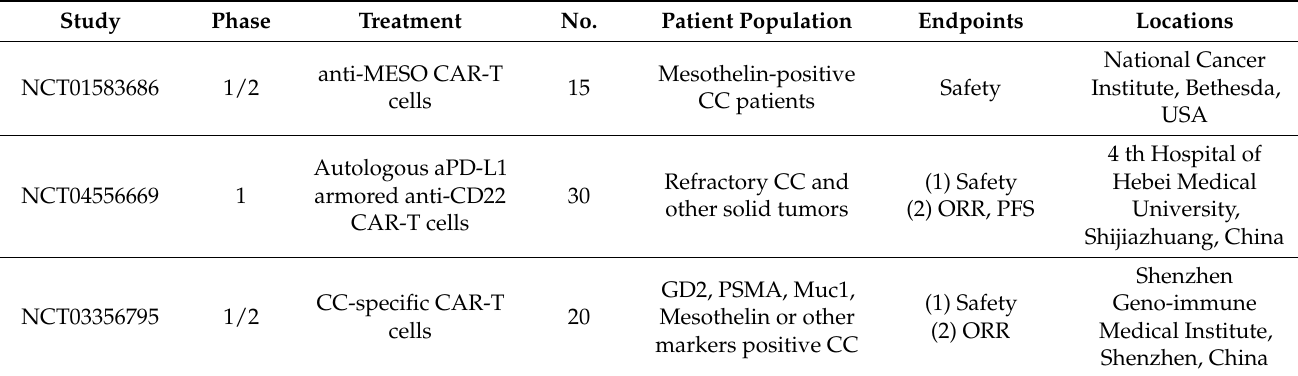
Table 4. Ongoing clinical trials testing CAR-T cell therapy in